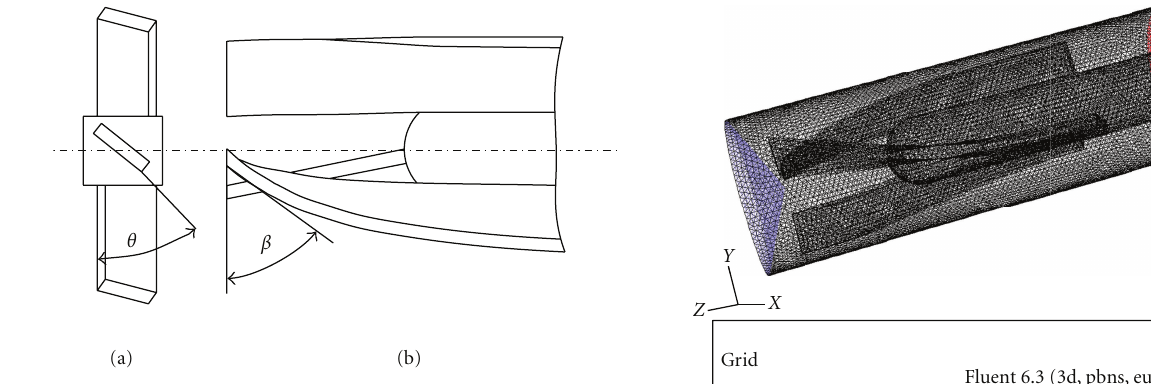
Figure 4: Pitched turbine type agitator (a) and turbulence genera- tor (b).